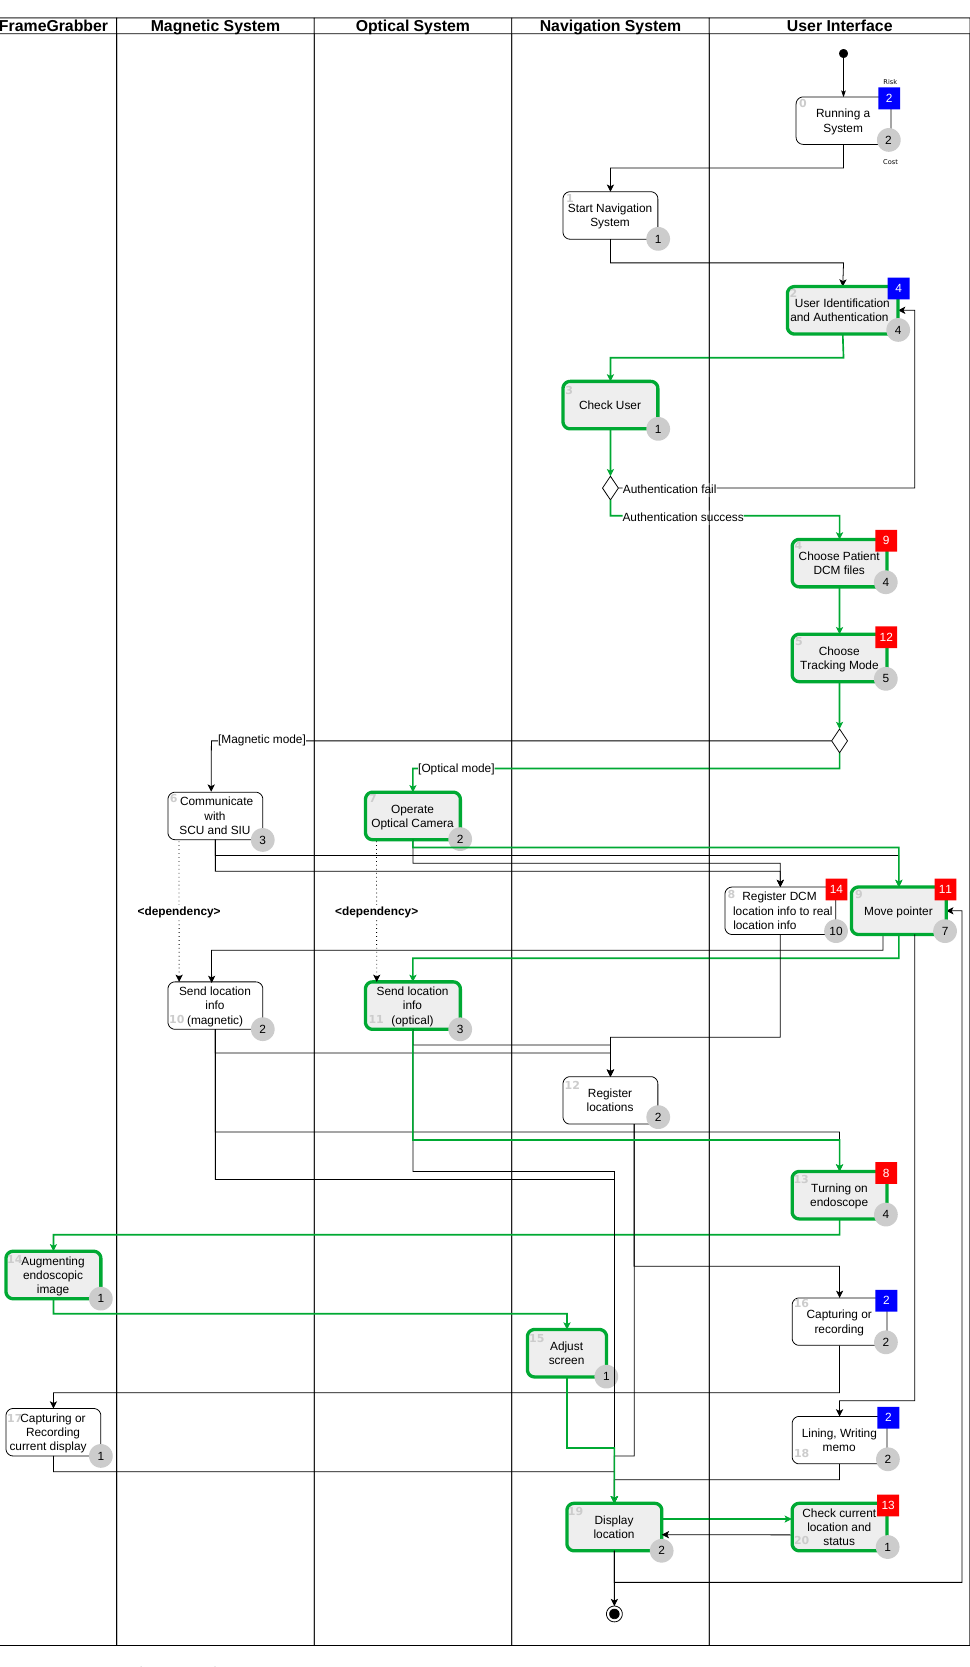
Figure 14. Final